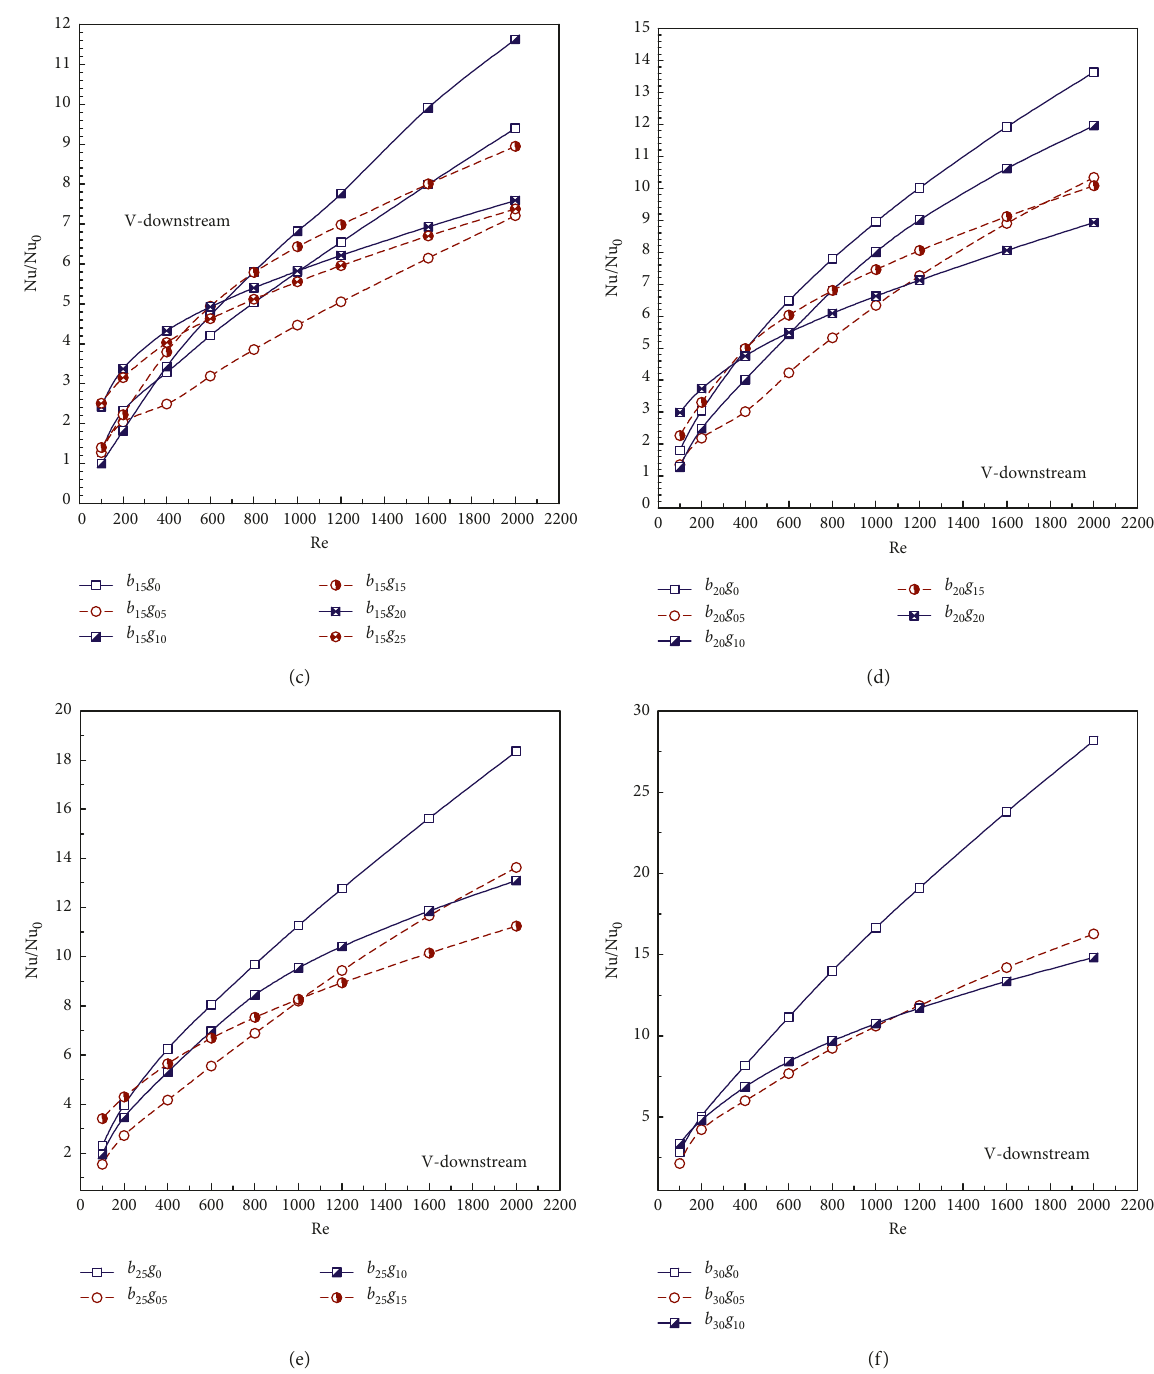
Figure 11: Relation of Nu/Nu